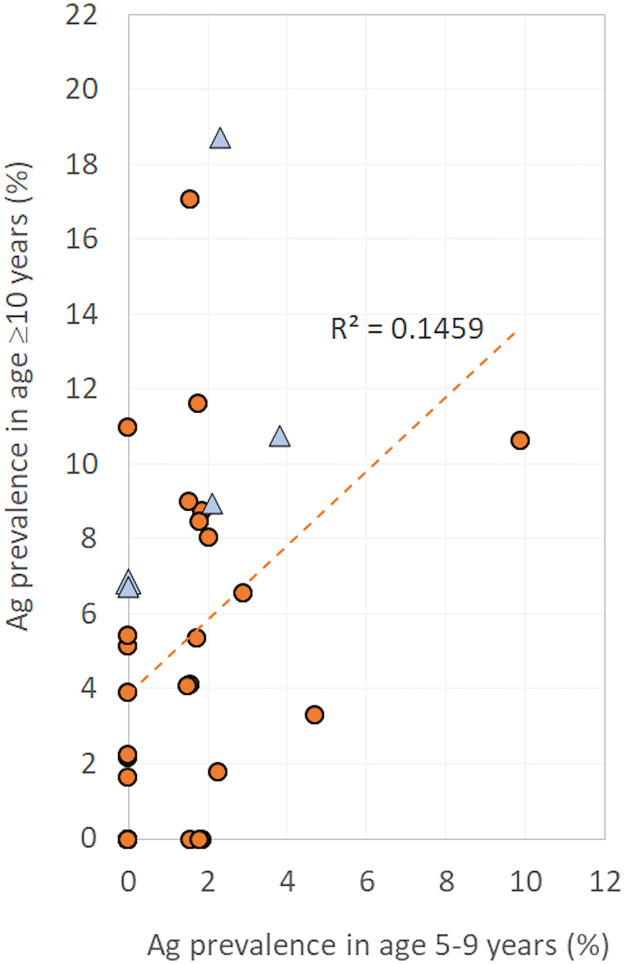
Correlation between adjusted Ag prevalence in participants aged 5–9 years and ≥10 years.Orange circles and blue triangles represent randomly selected and purposively selected villages, respectively.